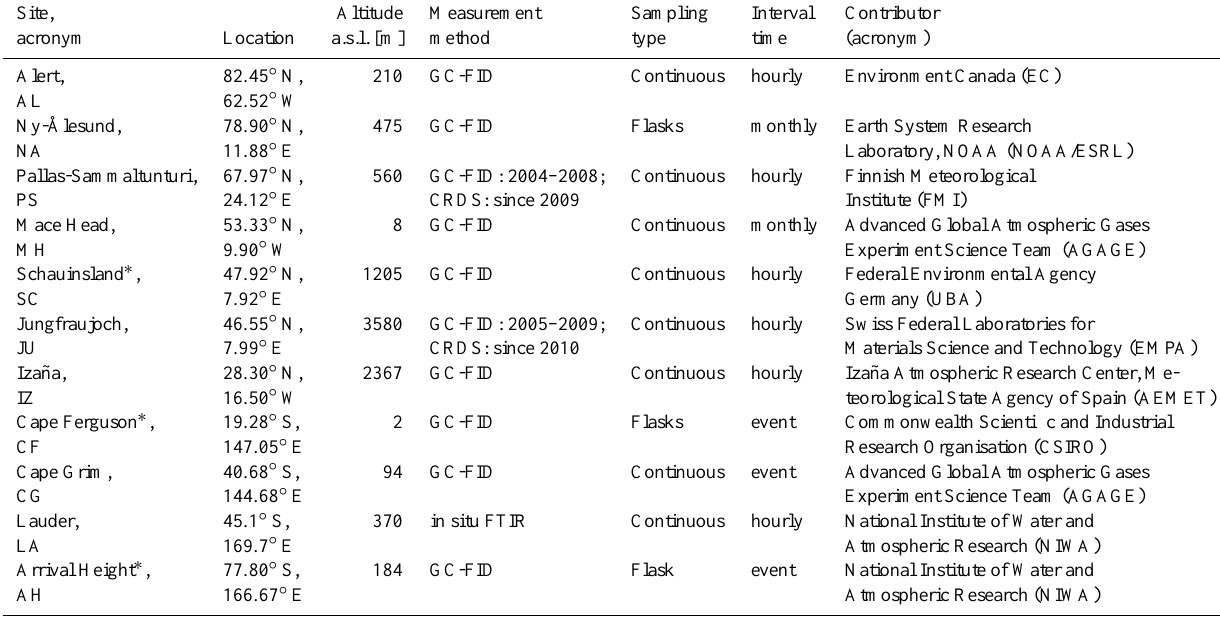
Table 4. In situ surface contributing sites. Instrument acronym: GC, gas chromatography; FID, flame ionisation detection; CRDS, cavity ring-down spectroscopy. Interval time means the time frequency of the data available used in this